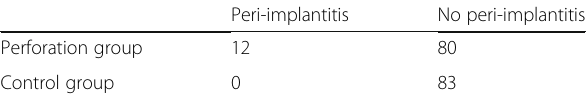
Table 6 Fisher ’ s exact test: incidence of peri-implant disease after sinus lifting procedure with and without membrane perforation ( p =